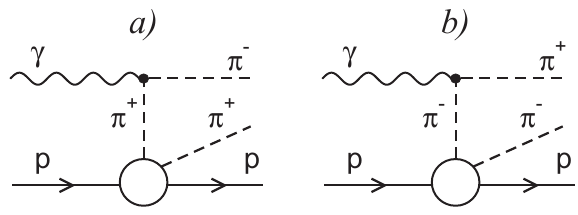
Figure 1. Feynman diagrams for the direct meson photoproduction (Deck